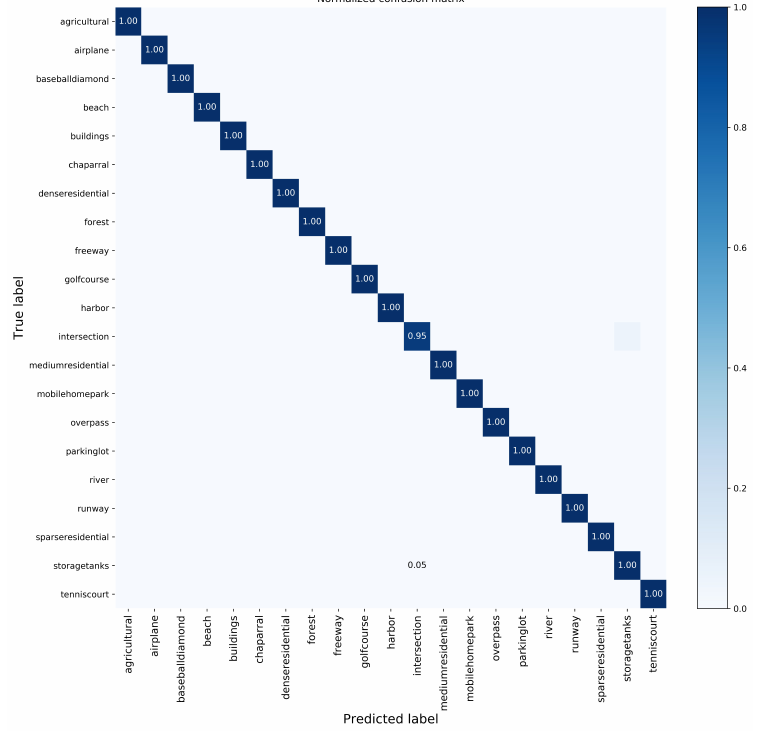
Figure 8. CM on the UC Merced dataset (accuracy = 99.76%).